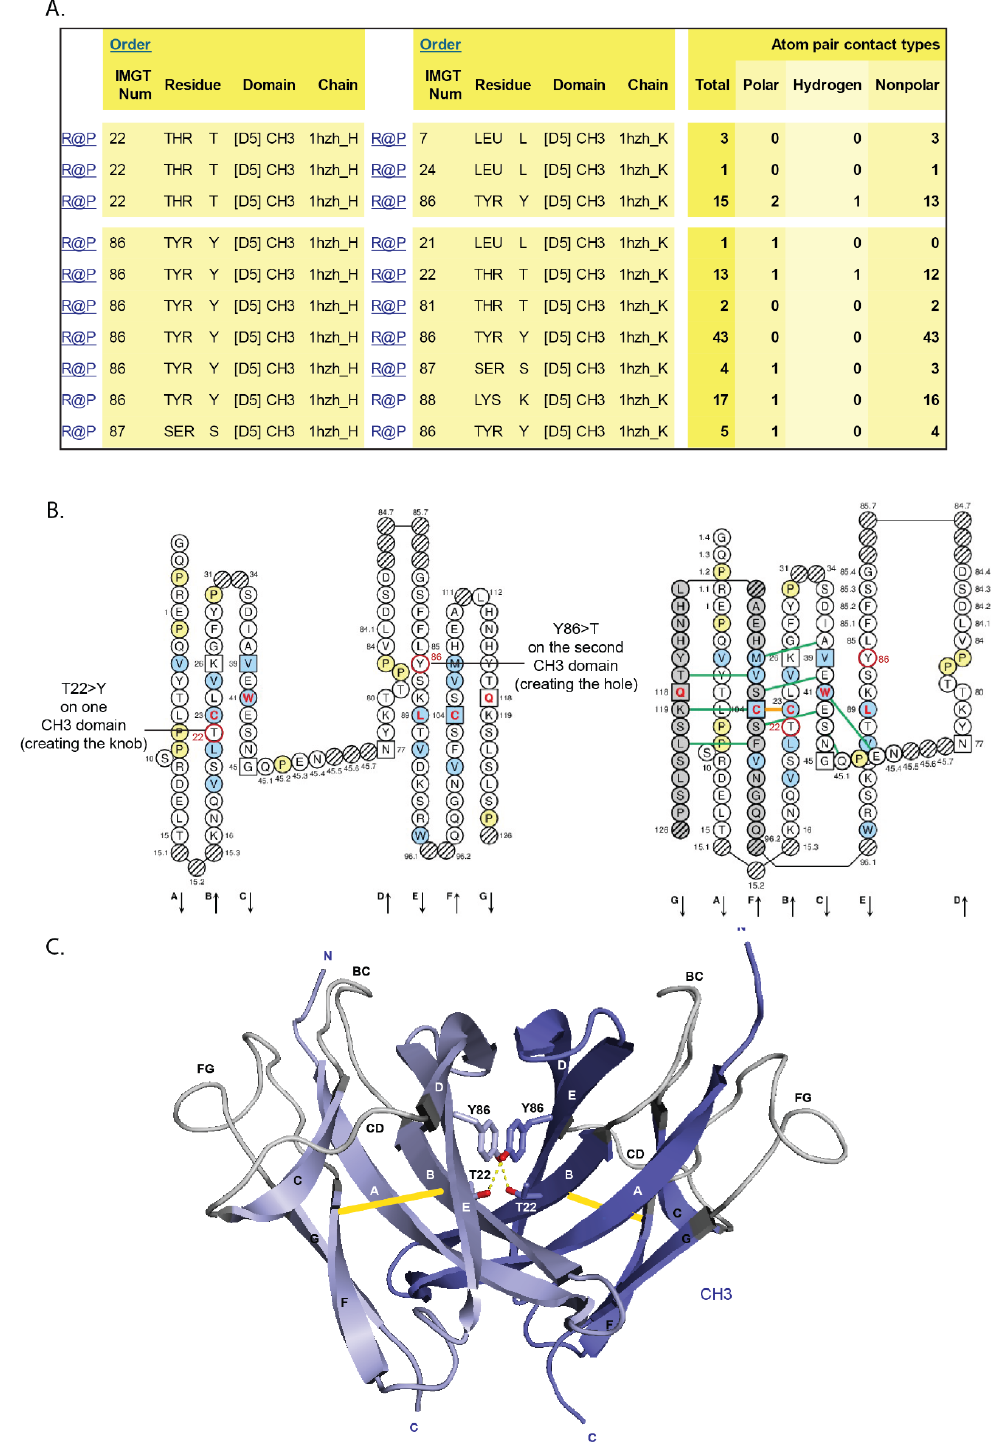
Figure 37. Homo sapiens IGHG1 CH3 and knobs ‐ into ‐ holes positions [94]. ( A ) Contact analysis of threonine T22 and tyrosine Y86 at the interface between the two CH3 domains of the gamma1 chains. T22 and Y86 are the two positions involved in the knobs ‐ and ‐ holes. ( B ) IMGT Colliers de Perles of Homo sapiens IGHG1 CH3 on one layer (on the left) and on two layers with hydrogen bonds (on the